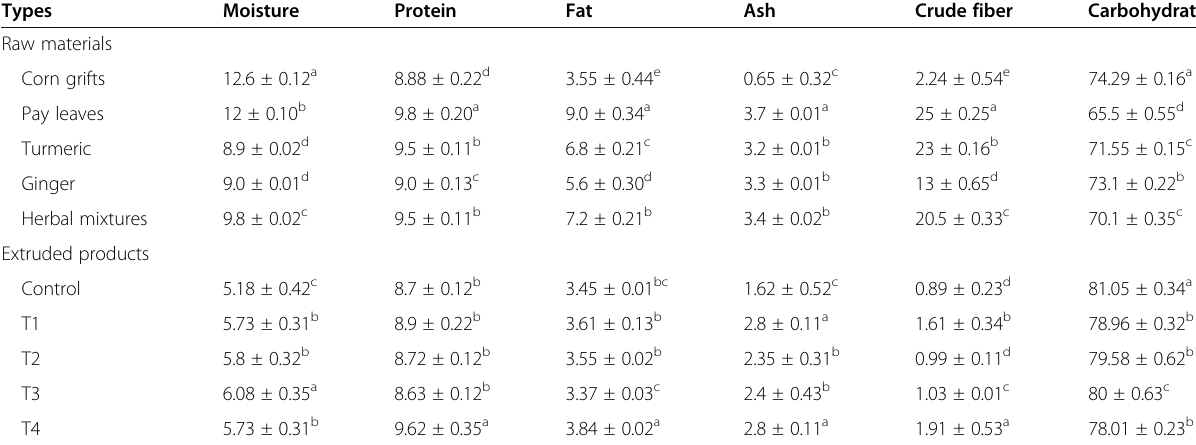
Table 3 Proximate analysis of raw components and extruded products (%)